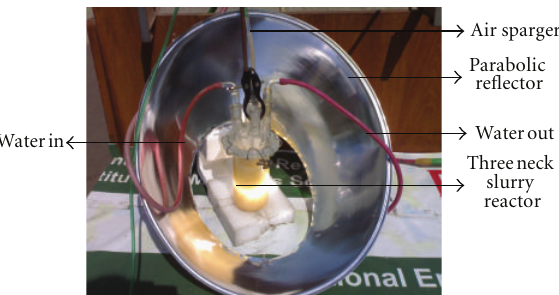
Figure 1: Experimental setup of the solar reactor for photocatalytic degradation